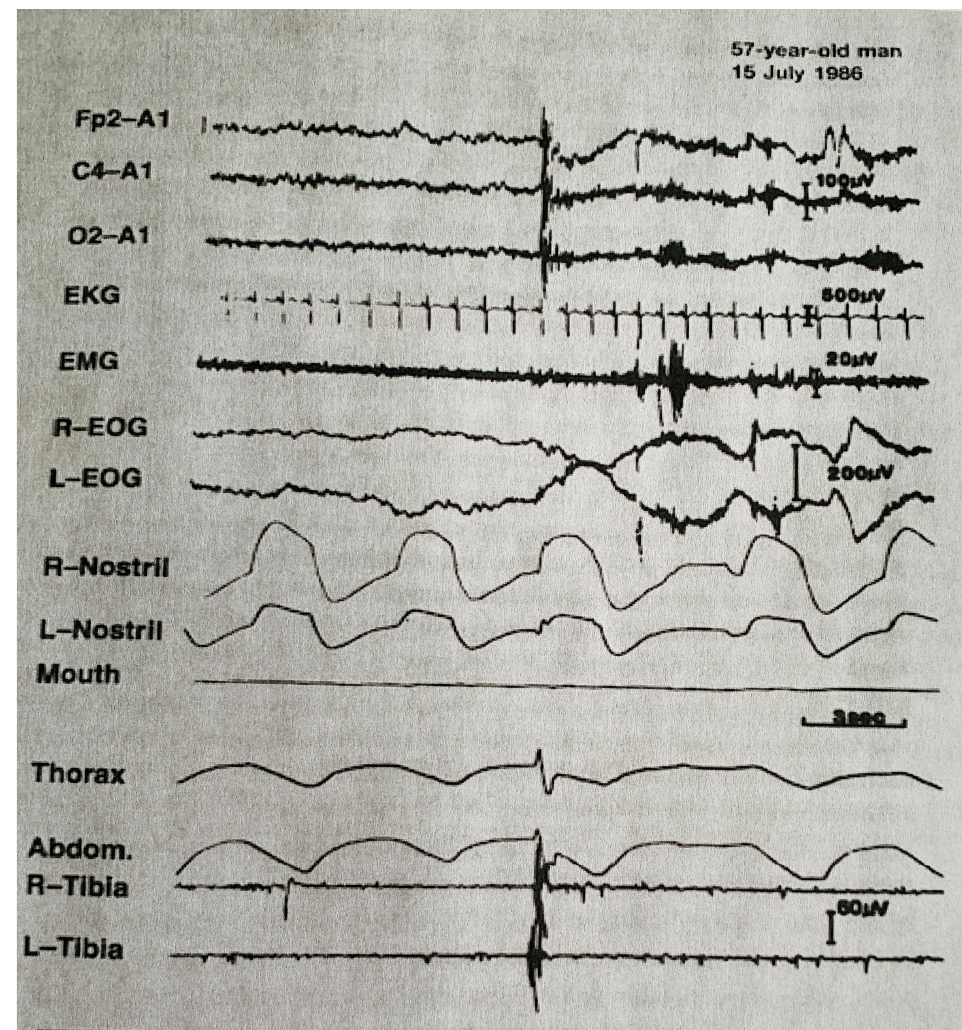
Figure 20. A sleep start, also called a hypnic jerk, in a 57 ‐ year old drowsy man recorded in July 1986. The jerk consists of total body myoclonus mainly affecting the legs but also often the arms, head and chest in an abrupt flexion. The phenomenon occurs apparently spontaneously during stage 1 somnolence at sleep onset. In this personally recorded example, the myoclonus is recorded as EMG potentials in the scalp electrodes, abrupt expiration in the chest and nasal leads, and as myoclonic EMG potentials recorded over the right and left anterior tibialis muscles. The subject is in stage 1 drowsiness prior to the massive sleep start and immediately afterward there is diffuse alpha activity and some eye movements which together indicate an arousal due to the jerk. As the name suggests, sleep starts are akin to the startle responses in wakefulness that are induced by unexpected intense stimuli. The cause of their occurrence in somnolence is uncertain but may well be due to endogenous stimuli from internal organs. Repeated sleep starts during somnolence may lead to a form of sleep onset insomnia with a consequent increase in daytime sleepiness. (Reproduced with permission from Broughton R. Some important underemphasized aspects of sleep onset. In: R Ogilvie and J Harsh (eds). Sleep Onset Mechanisms. American Psychological Association, Arlington VA 1994: 19–36, published by American Psychological